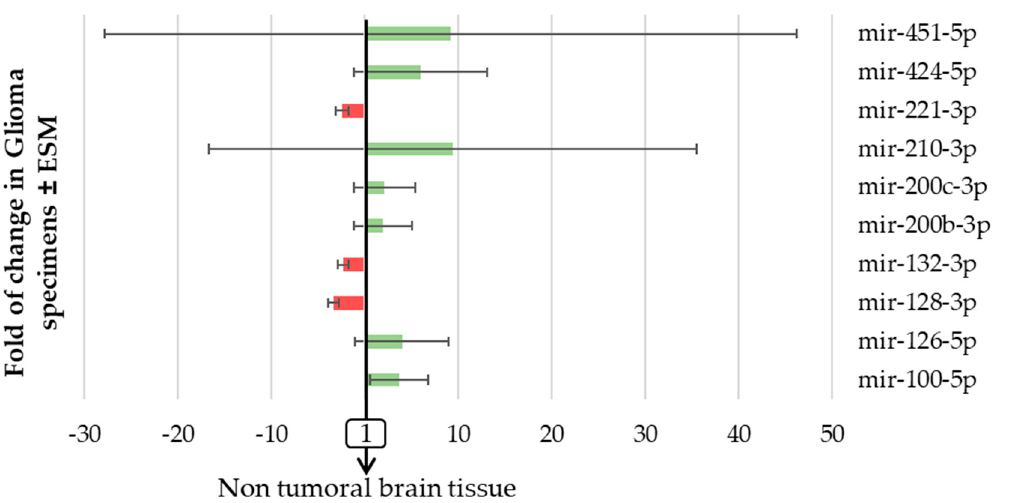
Figure 4. The expression of pro-angiogenic or pro-hypoxic miRNAs varied markedly in patients with glioma. miRNA from the 97 FFPE surgically resected tumor specimens or the 8 healthy brain tissues were extracted using miRNAeasy-FFPE kit (Qiagen™), then retrotranscribed (RT) and amplified (PCR) using the TaqMan MiRNA reverse transcription kit (Applied Biosystem). The RT-PCR data were normalized to the small nucleolar house-keeping RNA, RNAS RNU48 (SNORD48) (assay ID 001006). Results are expressed as the fold change in glioma samples ± ESM compared to healthy brain tissue.